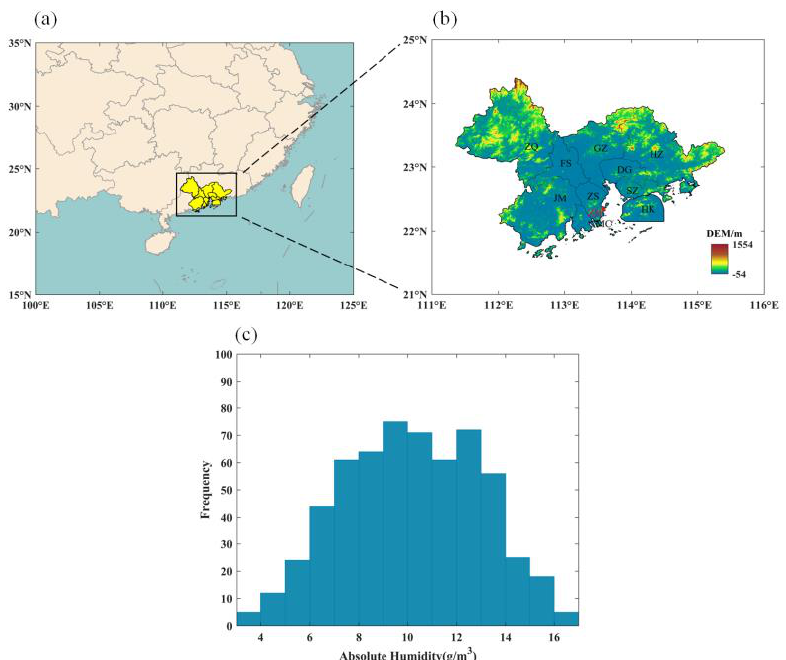
Figure 1. ( a , b ) Map of the Guangdong – Hong Kong – Macau Greater Bay Area. ( c ) The frequency of daily mean absolute humidity values for all study periods.